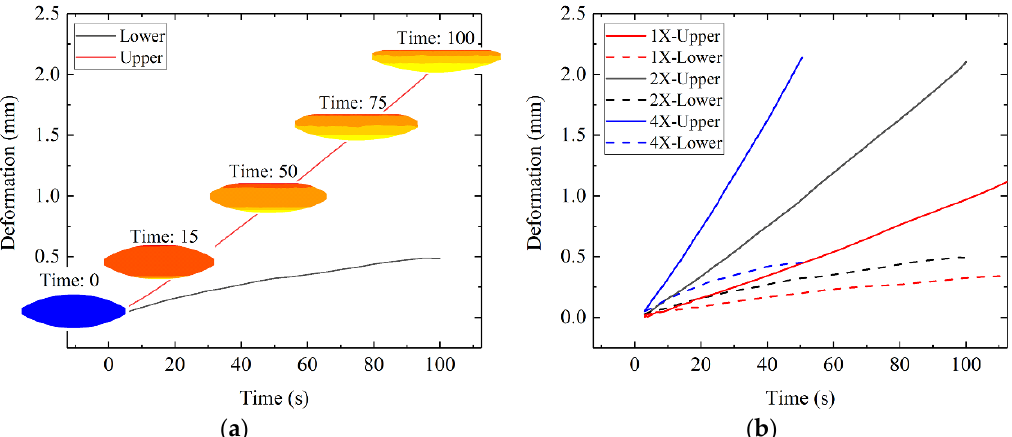
Figure 7. ( a ) The deformation diagram of the glass preform in the 2X experiment; ( b ) The deformation of the glass preforms in the three experiments.